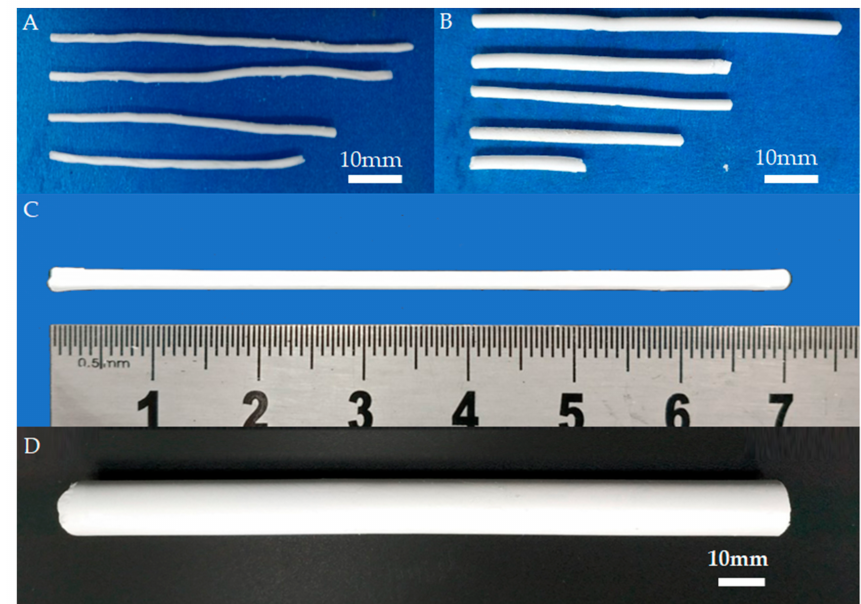
Figure 4. BIN image without ( A ) or with ( B ) cooling gradually in the sintering process. ( C ) Outward appearance of the as-sintered BIN after the optimized freeze-drying process. ( D ) The image of BIN with a diameter of ~12.8 mm and length of ~154